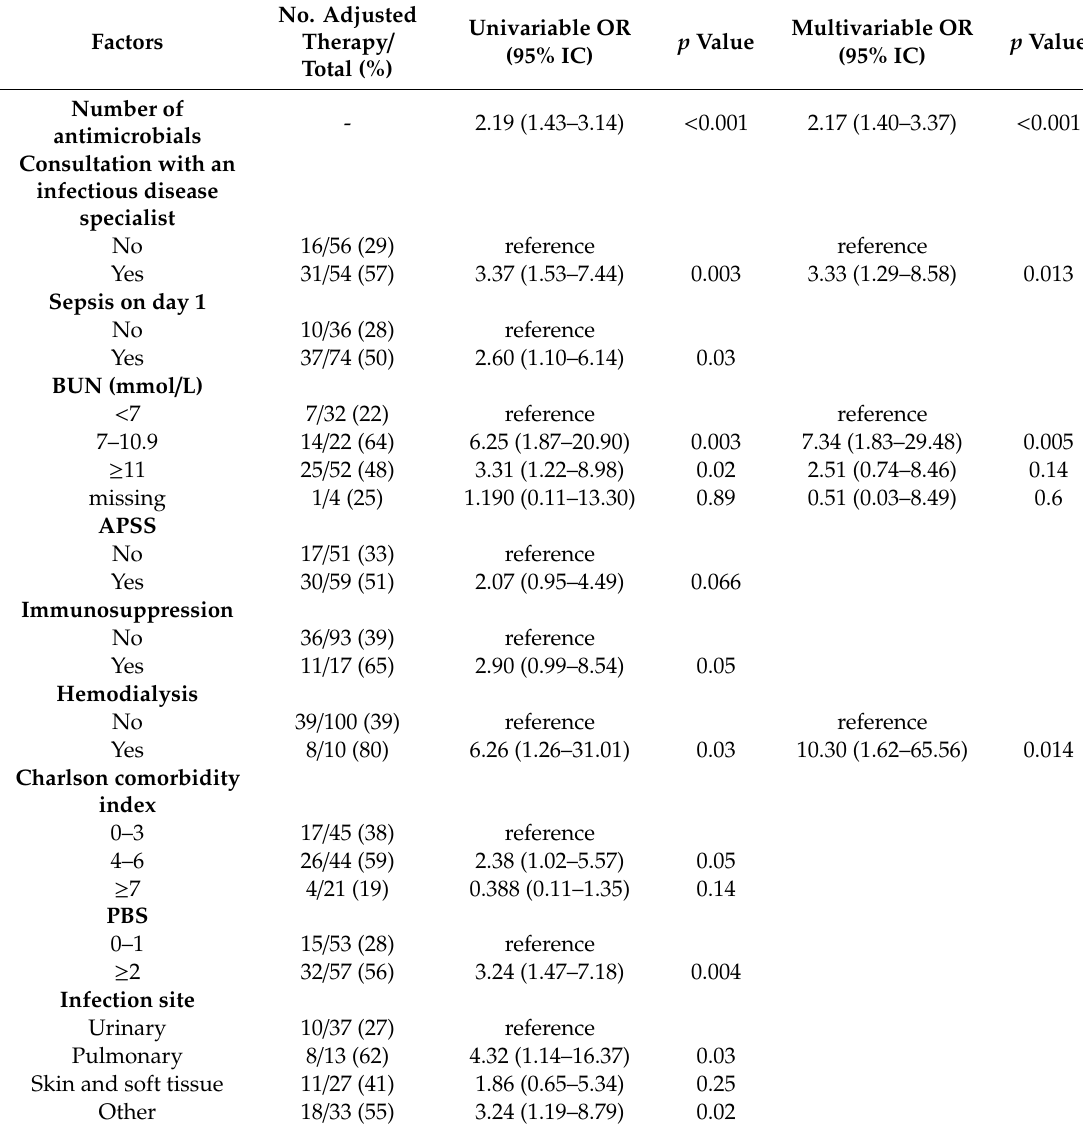
Table 4. Factors associated with adjusted antimicrobial